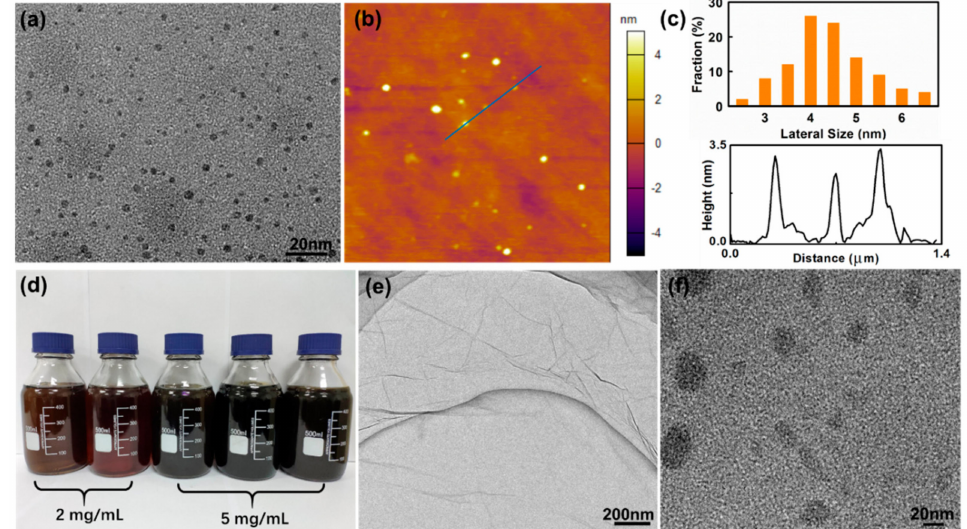
Figure 1. ( a ) Transmission electron microscope (TEM) and atomic force microscope (AFM). ( b ) Images of graphene oxide quantum dots (GO-QDs) synthesized from aphanitic graphite (AG). ( c ) Lateral size and height distribution. ( d ) Mass produced GO-QDs aqueous solution. ( e ) TEM image of GO synthesized from flake graphite (FG). ( f ) GO nanosheets synthesized from FG. (Separated at 15,000 rpm for 30